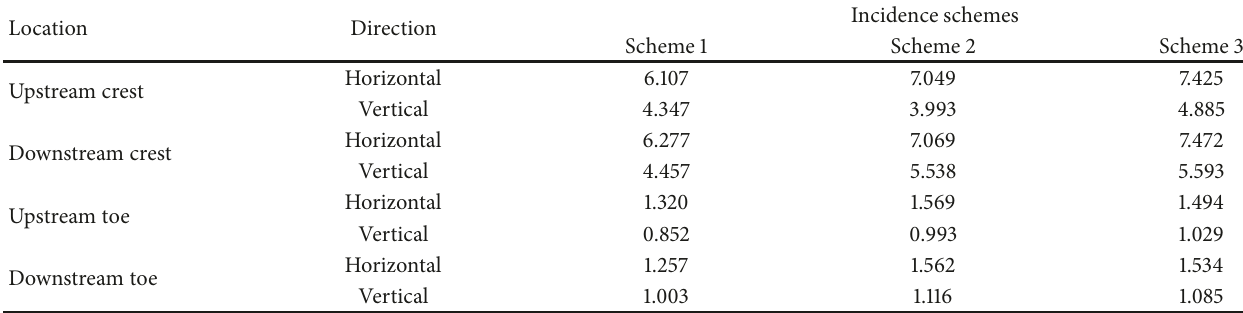
Table 4: Acceleration extremums of key parts of the dam (unit: m/s 2 ). Incidence schemes Location Direction Scheme 1 Scheme 2 Scheme